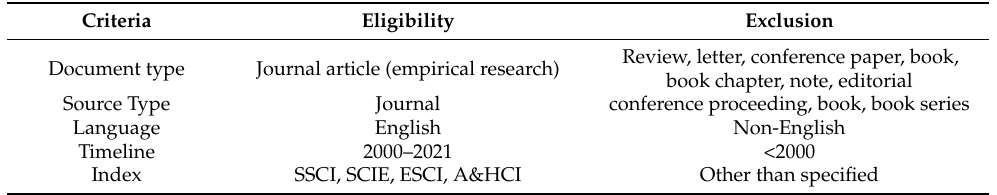
Table 1. Inclusion and exclusion